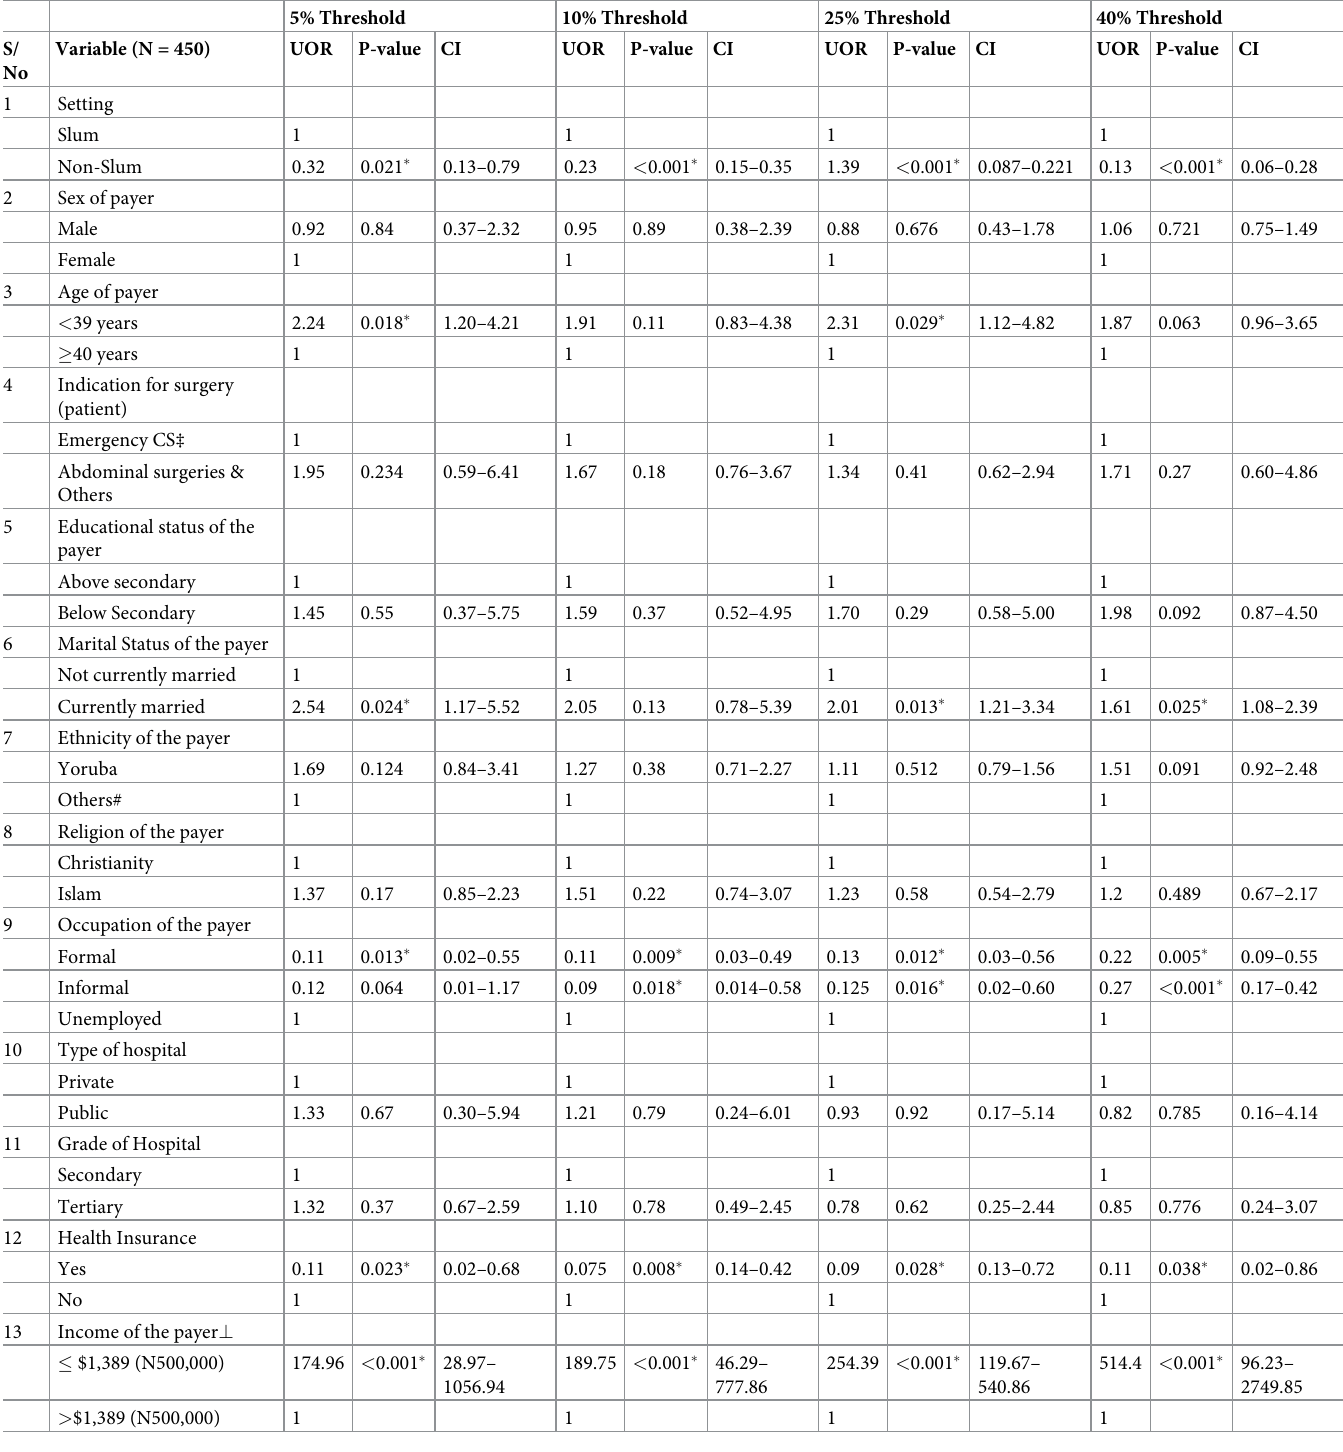
Table 3. Unadjusted Odds Ratios (UOR) for respondents at all